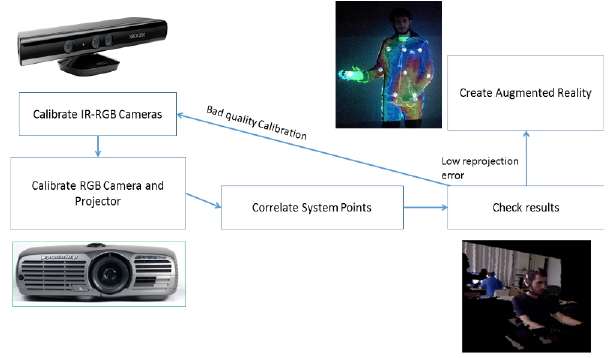
Figure 13 – System’s